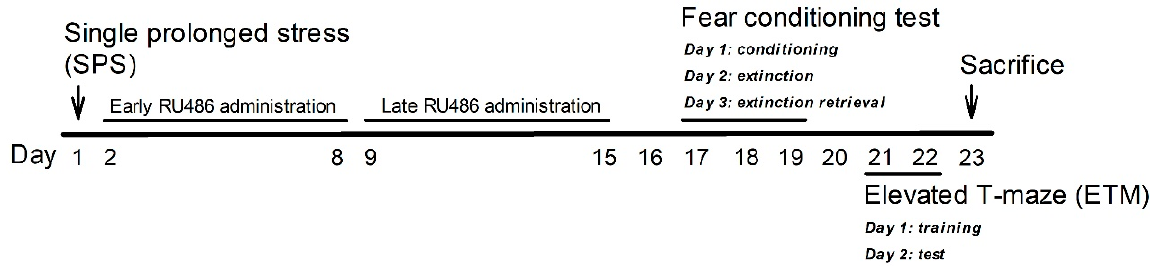
Figure 7. Schematic illustration of the experimental design in the present study.